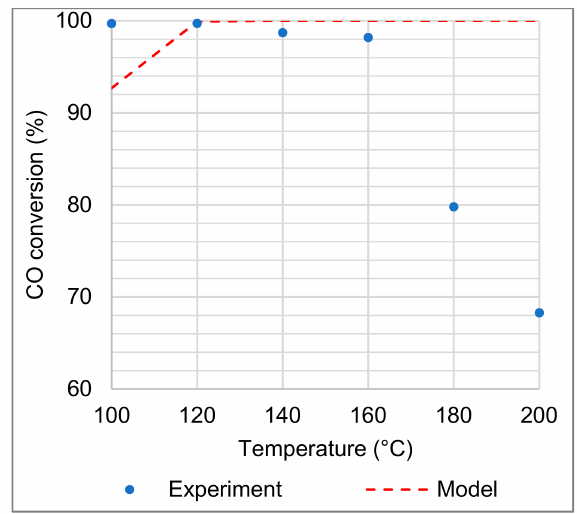
Figure 6. CO conversion measured experimentally and modelled using only CO and H 2 oxidation reactions (neglecting the reversible WGS), for a space velocity of 32.6 NL g cat − 1 h − 1